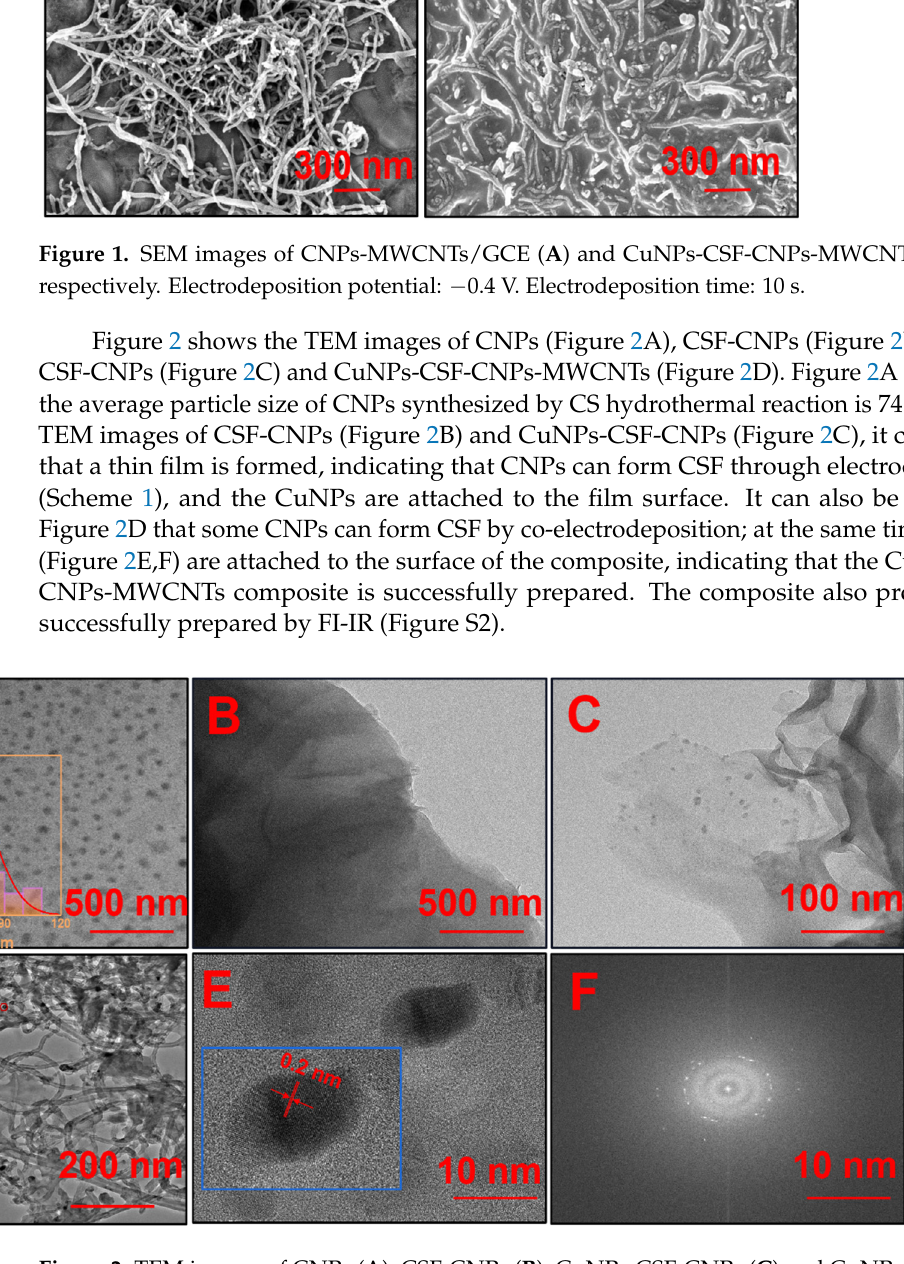
Figure 2. TEM images of CNPs ( A ), CSF-CNPs ( B ), CuNPs-CSF-CNPs ( C ) and CuNPs-CSF-CNPs- MWCNTs ( D ). HRTEM ( E ) and SAED image of CuNPs in CuNPs-CSF-CNPs-MWCNTs ( F ).